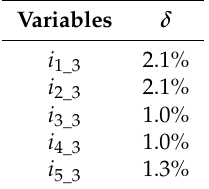
Table 6. Relative error of phase current in normal